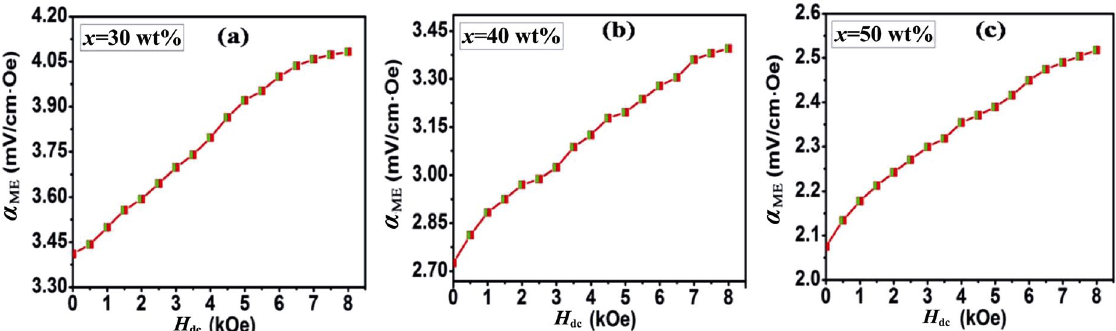
Fig. 10 Variation of α ME with DC magnetic field for (1 ̶ x )KNN–( x )BHF composites at room temperature: (a) x = 30 wt%, (b) x = 40 wt%, and (c) x = 50